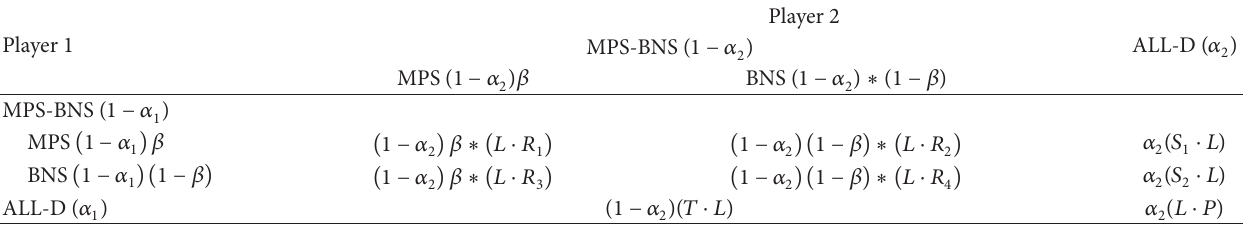
(cid:20)(cid:15)(cid:20)(cid:15) (cid:46)(cid:49)(cid:52)(cid:14)(cid:35)(cid:47)(cid:52) (cid:66)(cid:72)(cid:66)(cid:74)(cid:79)(cid:84)(cid:85) (cid:52)(cid:70)(cid:77)(cid:277)(cid:84)(cid:73)(cid:79)(cid:70)(cid:84)(cid:84)(cid:15) In this section, the